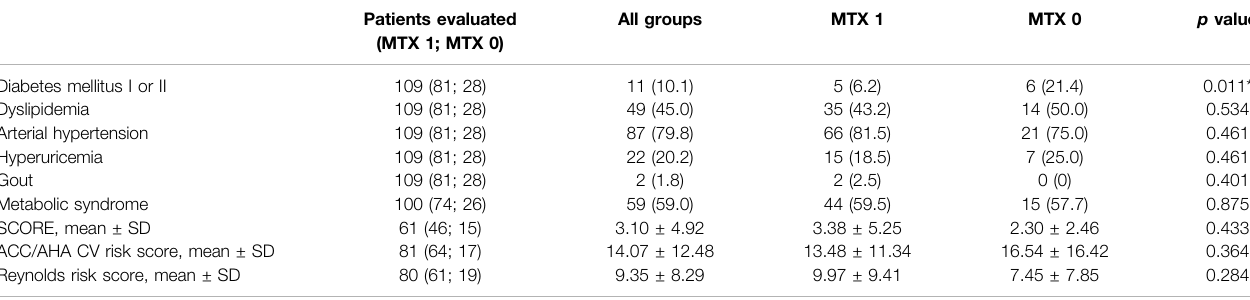
TABLE 3 | Risk factors for the development of cardiovascular diseases between groups of RA patients treated (MTX 1 group) or non-treated (MTX 0 group) with MTX. Patients evaluated All (MTX 1; MTX 0)